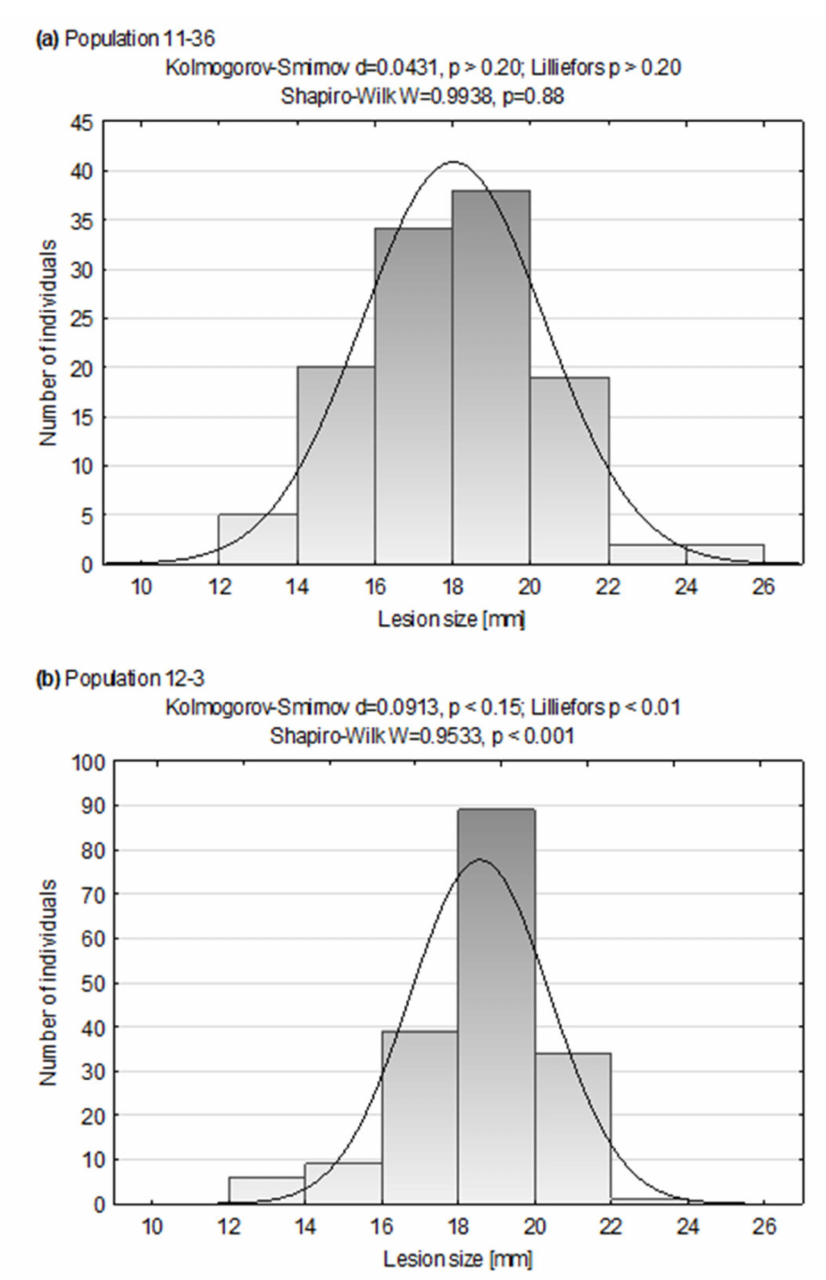
Figure 1. Phenotypic distribution of mean (2017–2019) dry rot lesion size in tubers of potato individ- uals in populations ( a ) 11–36, N = 120 and ( b ) 12–3, N = 178. Results of normality tests are shown above the charts; fitness to the normal curve is indicated by a